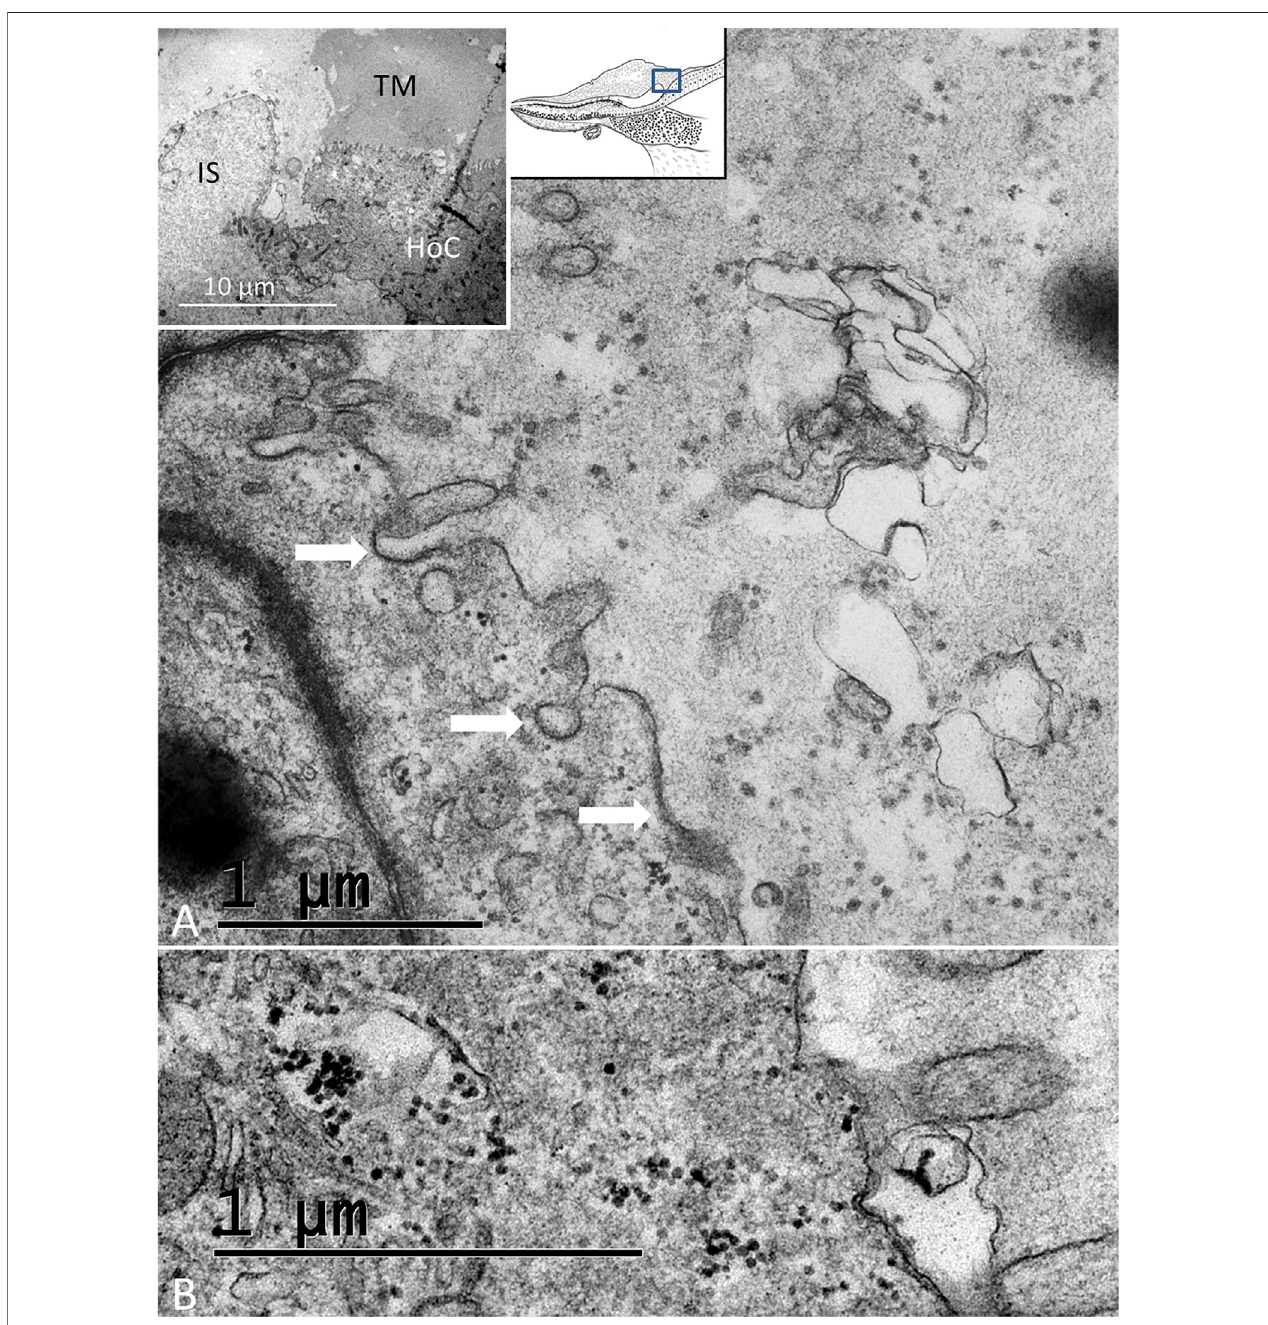
FIGURE 10 | (A) . Electron microscopy of an HoC showing secretory activity. Several coated vesicles and pits (arrows) are seen at the apical cell surface. The TM contains apoptotic vesicles and electron-dense granules. Inset shows the transition zone between the HoC and IS. Microvesicles aggregate in the apical cytoplasm (white arrow) and empty their content of granules into the lumen (dark arrow). (B) . Dense particles in the apical cytoplasm of a hyaline cell and in the lumen.